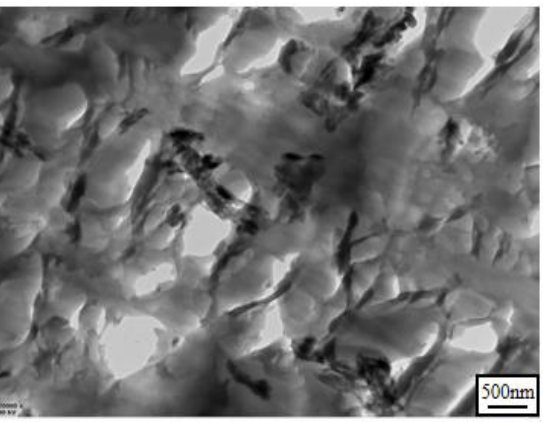
Figure 7. TEM image of the fracture surfaces of EP/DDS/HPCP − 6/H − U − 3.